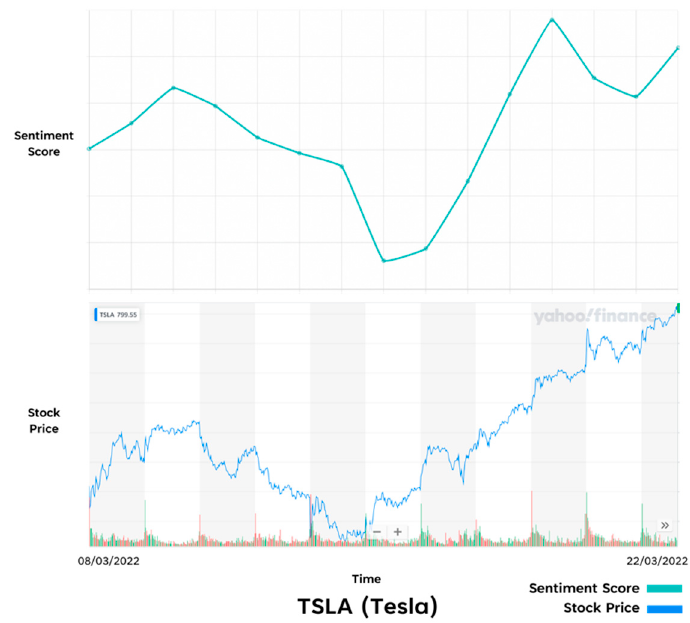
Figure 16. Comparison of Prototype results and Real-Life results—TSLA.